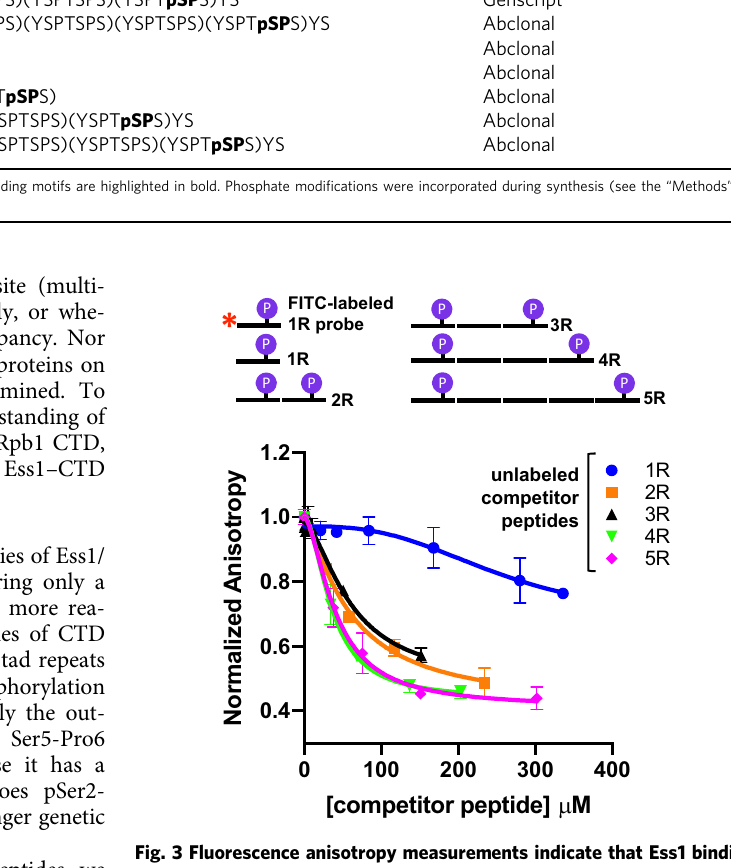
1R – 5R CTD peptides phosphorylated at the Ser5 positions of the